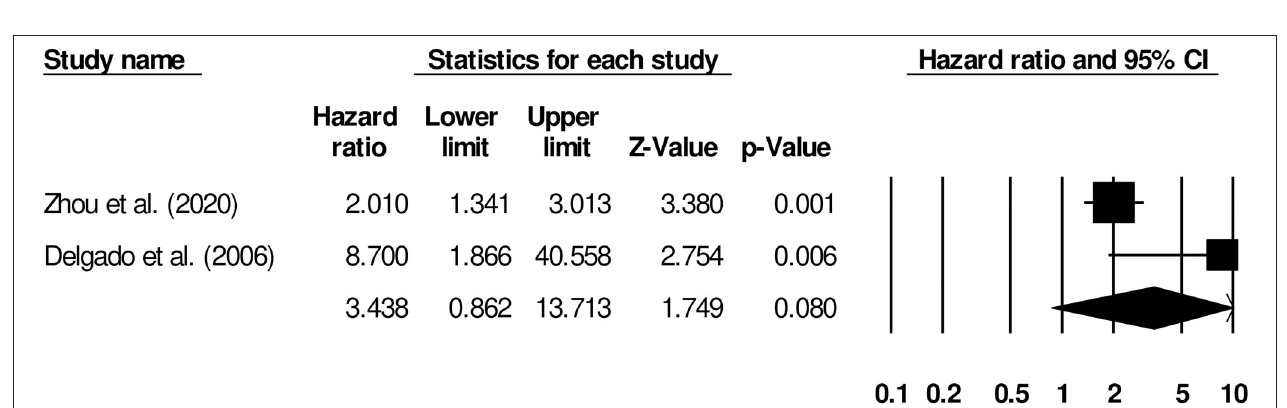
FIGURE 12 | Forest plot for studies evaluating the impact of D-dimer level on post-stroke mortality outcomes at 3 months follow up. Hazard ratios are presented as black boxes while 95% confidence intervals are presented as whiskers. A small hazard ratio represents a lower influence of D-dimer levels on stroke patient functional outcome while a higher hazard ratio represents a higher